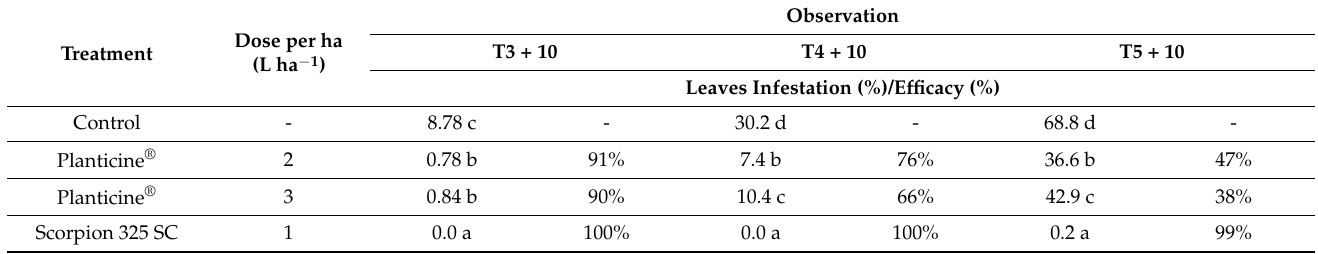
Table 3. Average percentage of tomato leaves infestation by Oidium neolycopersici and efficacy in powdery mildew limitation depending on the application of Planticine ® and chemical